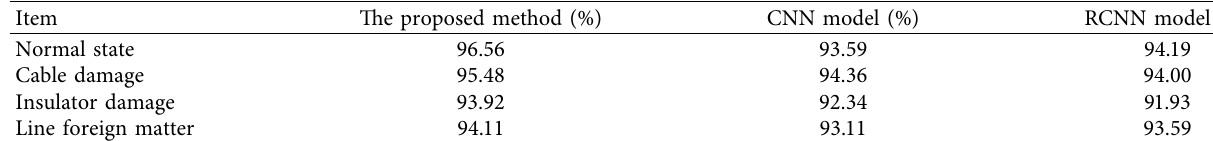
Figure 7: Variation of loss function loss Table 2: Identifcation results of diferent models.